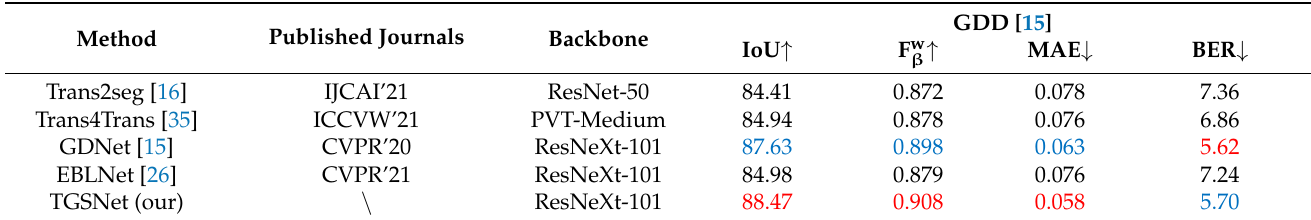
Table 2. Comparison results of our algorithm with open-source glass and transparent object segmen- tation methods on the GDD dataset. The red color marks the best results, and the blue color marks the second-best results.